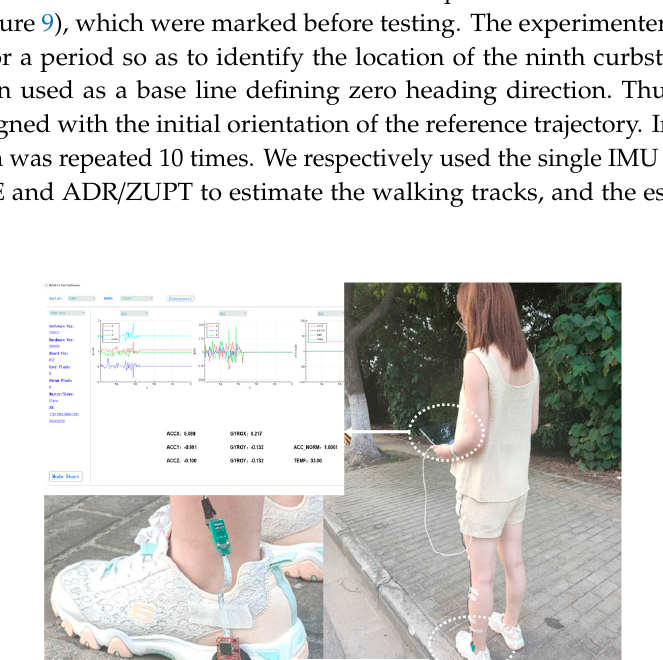
Figure 7. Walking experiments devices.